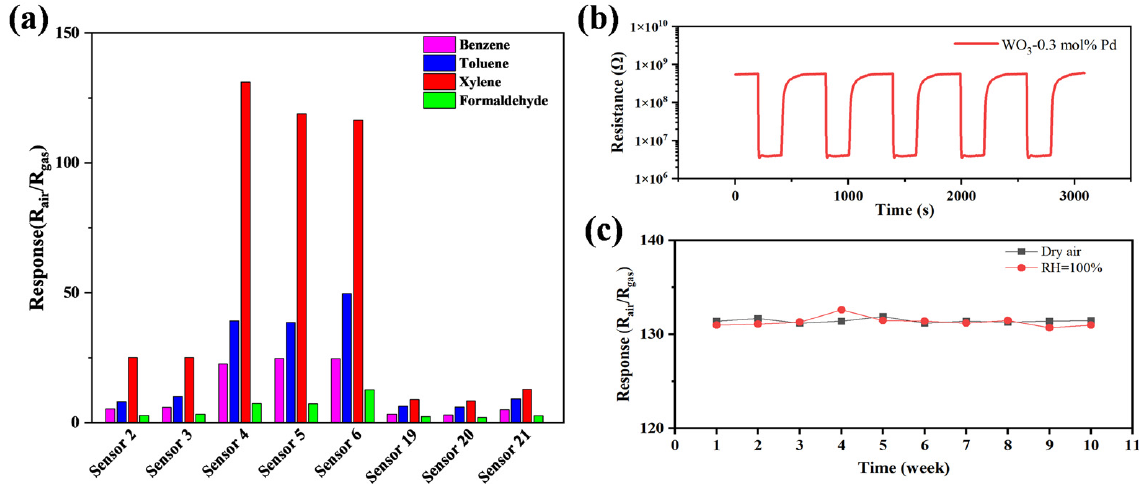
Figure 10. ( a ) Selectivity of the eight sensors to 100 ppm of the tested gases, ( b , c ) response and recovery cycles of WO 3 -0.3 mol% Pd to 100 ppm of xylene at 250 °C.